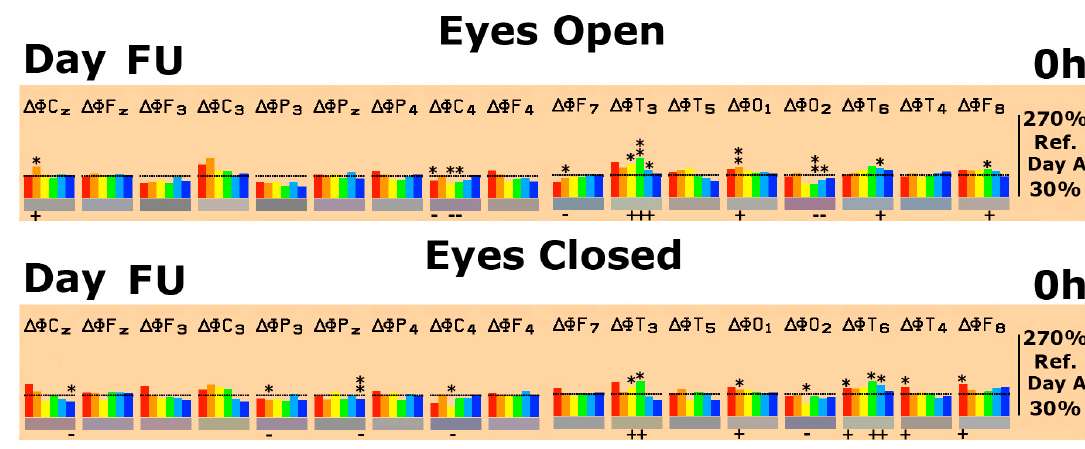
Figure 5. Data during eyes open and eyes closed conditions at baseline compared with follow-up (day FU) in comparison with day A (100%). Statistical significance between FU in comparison to day A is depicted for each brain region and each frequency range. Statistical difference in FU data is marked as: * p < 0.12; ** p < 0.05.